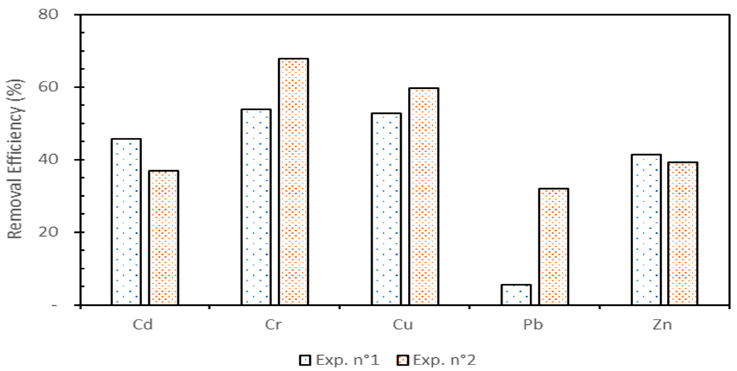
Figure 5. Metal removal efficiencies after each test.